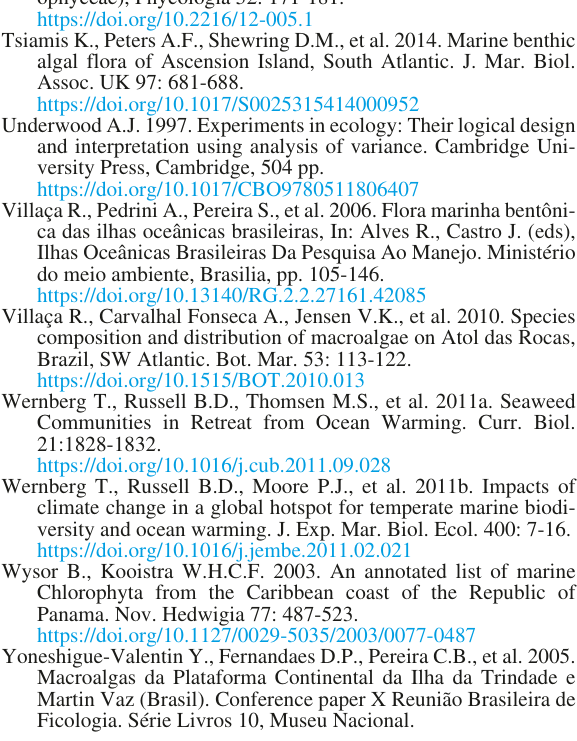
Table S1. – List of seaweed species already reported from Trindade Island, southwestern Atlantic, complementary to the new occur- rences recorded in the present study. Fig. S1. – Larger and conspicuous seaweeds that grow on top of the turf and rhodolith beds along the midlittoral and shallow sublittoral (A, Dictyotales; B, Caulerpa verticillata ; C, Tribe Laurencieae). Scale = 1